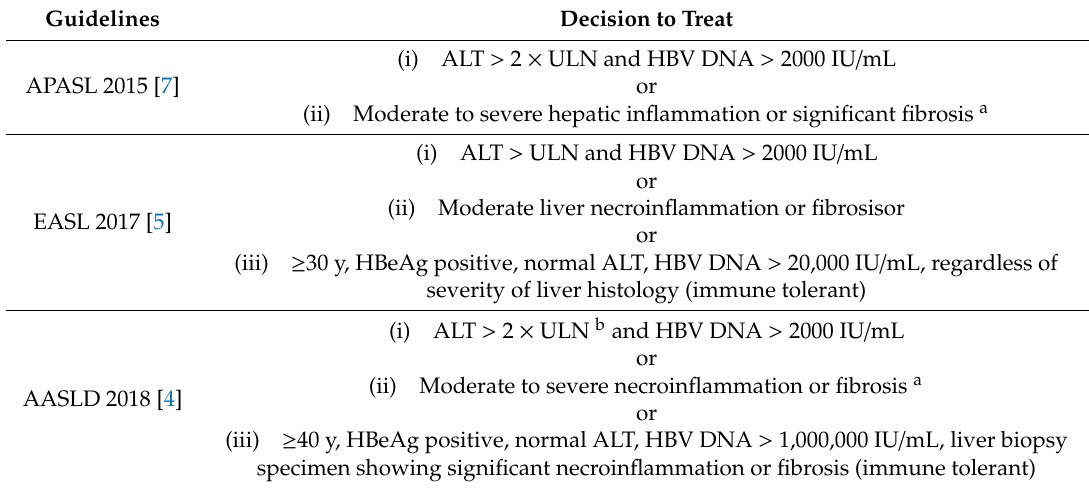
Table 1. International guidelines for treating chronic hepatitis B (CHB) e-antigen negative